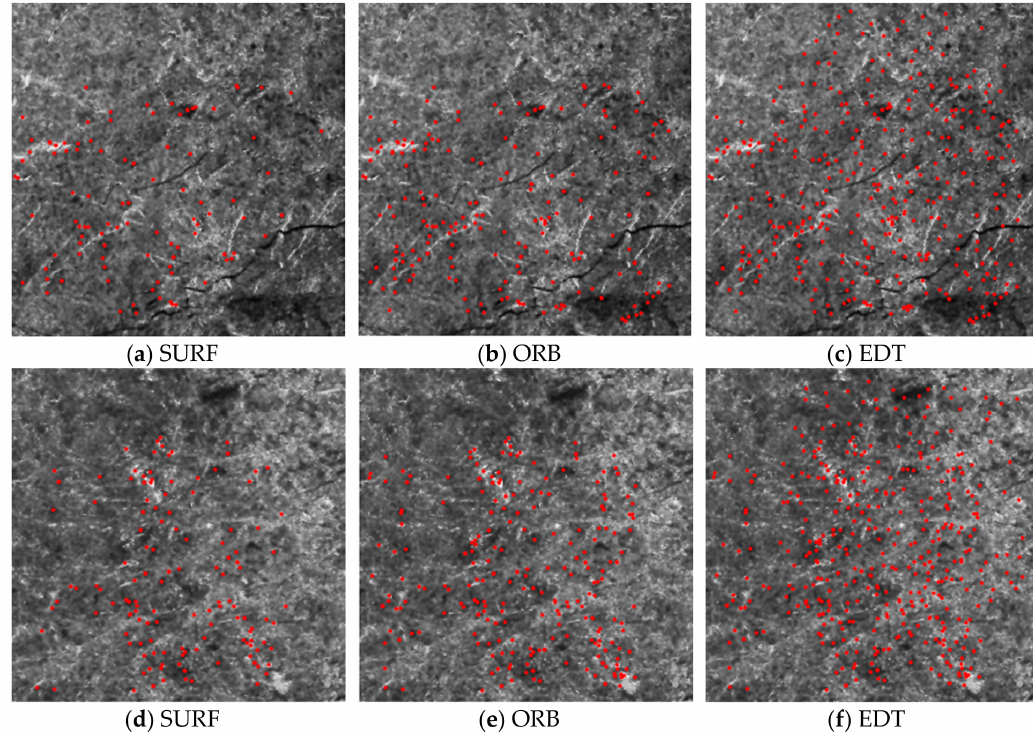
Figure 10. The results of feature points tracking with SURF, ORB, and EDT methods. Results of ( a ) SURF, ( b ) ORB and ( c ) EDT methods for case 1. Results of ( d ) SURF, ( e ) ORB and ( f ) EDT methods for case